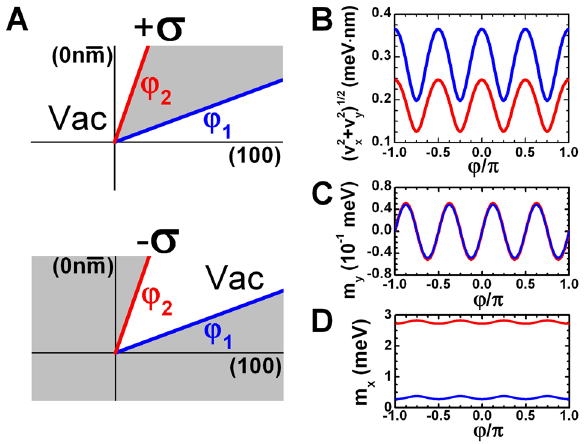
Figure 3. Orientation of the corner edge of (0mn)-oriented prototype QWs. ( A ) Schematic of two edges with a common corner with respect to main crystallographic axes in the QW plane. The sample and external vacuum σ (see σ and are shown in grey and white, respectively. External and internal angles differ by the parameter − + ϕ for the (001)-oriented three- v 2 v 2 the text). ( B – D ) Dependence of m x , m y and x + y on the edge orientation layer InAs/GaInSb (in red) and double HgTe/CdHgTe QW (in blue) with the layer thicknesses marked by the (cid:31) 16.9 , red symbols in Fig. 1B,C. The edge independent parameters ( v 0 , v z ) equal to (36.6, 68.1) meV nm and ( − 200.3) meV nm for the three-layer InAs/GaInSb and double HgTe/CdHgTe QW, respectively. This means a good , v 2 v 2 v 0 v z approximation of for both x + y ≪ | | | | (cid:31)